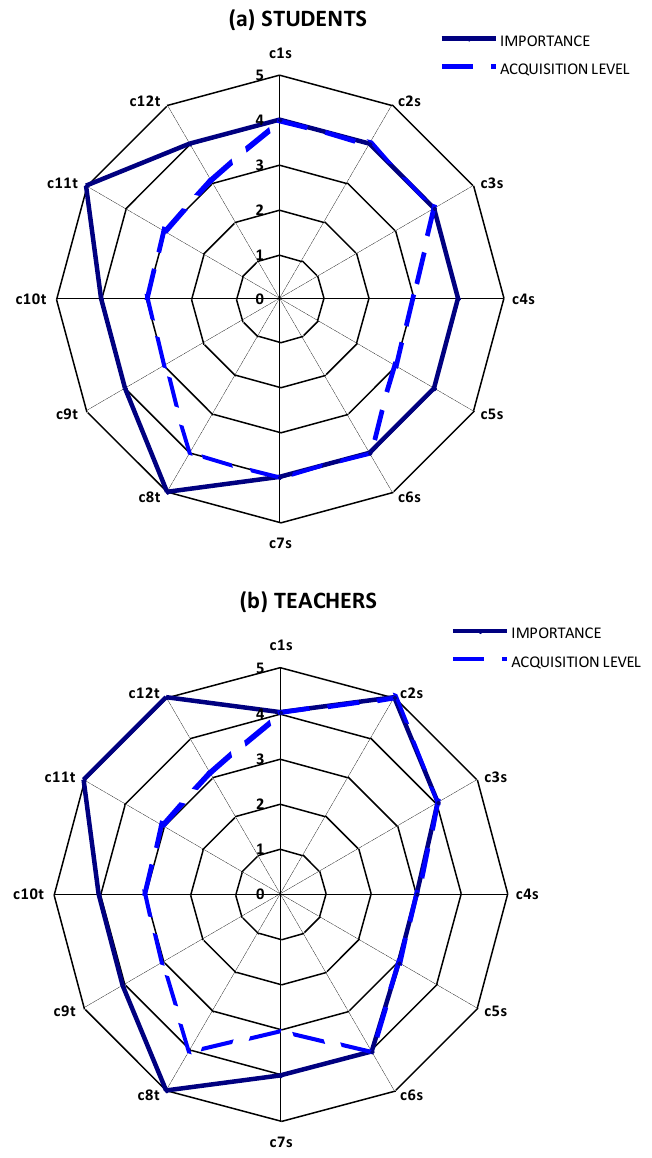
Fig 3. Results of the skill evaluation procedure for the Applied Chemical Kinetics subject (a) Students (b)